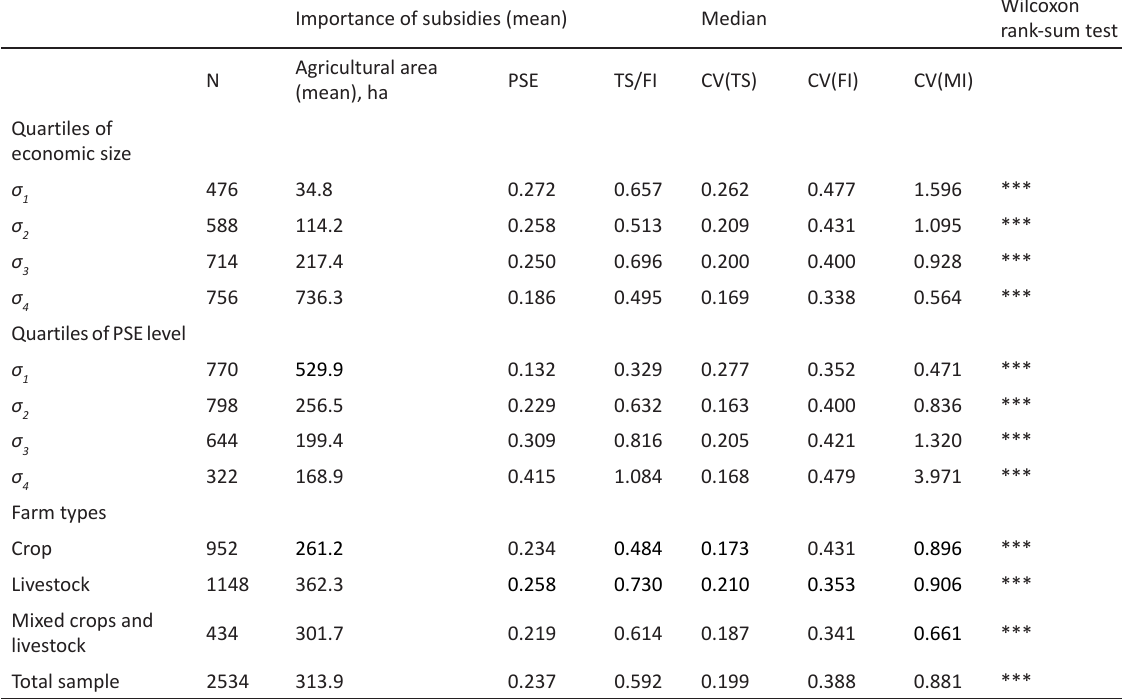
Wilcoxon rank-sum test